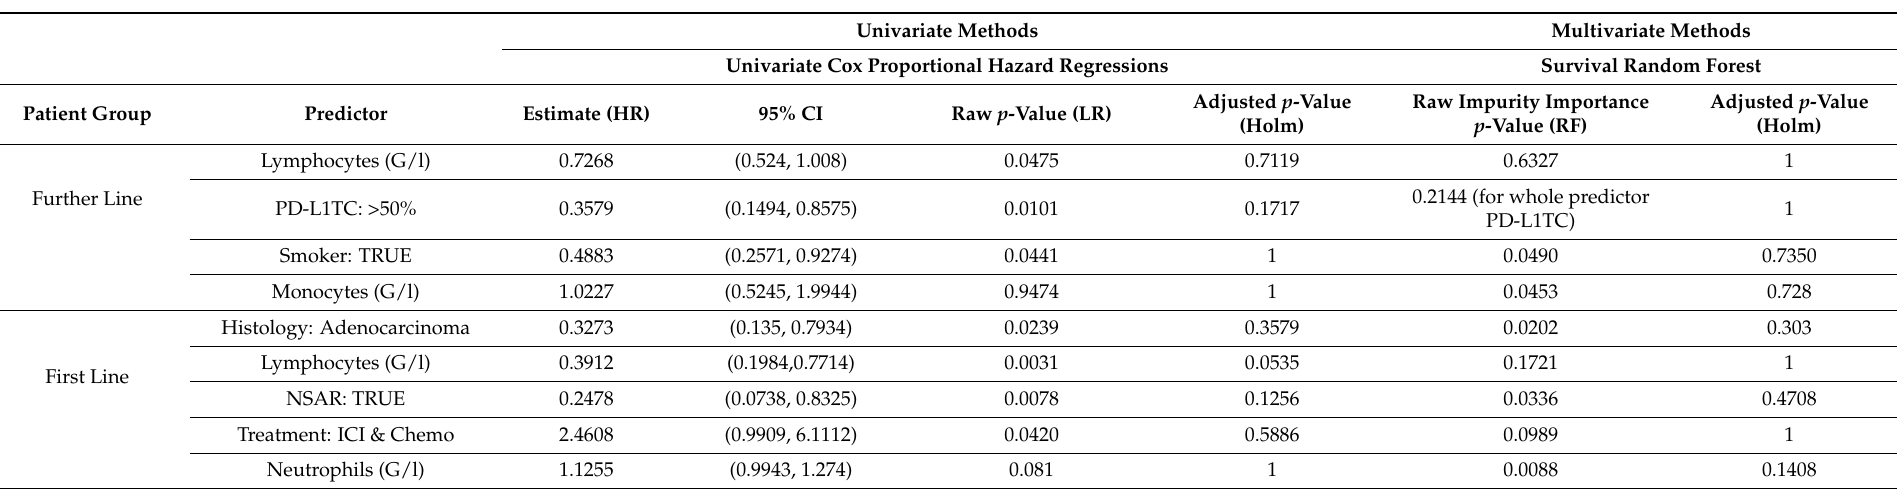
Table 3. Significant results for overall survival for the first- and further-line patient groups (complete list of results is presented in Tables S8 and